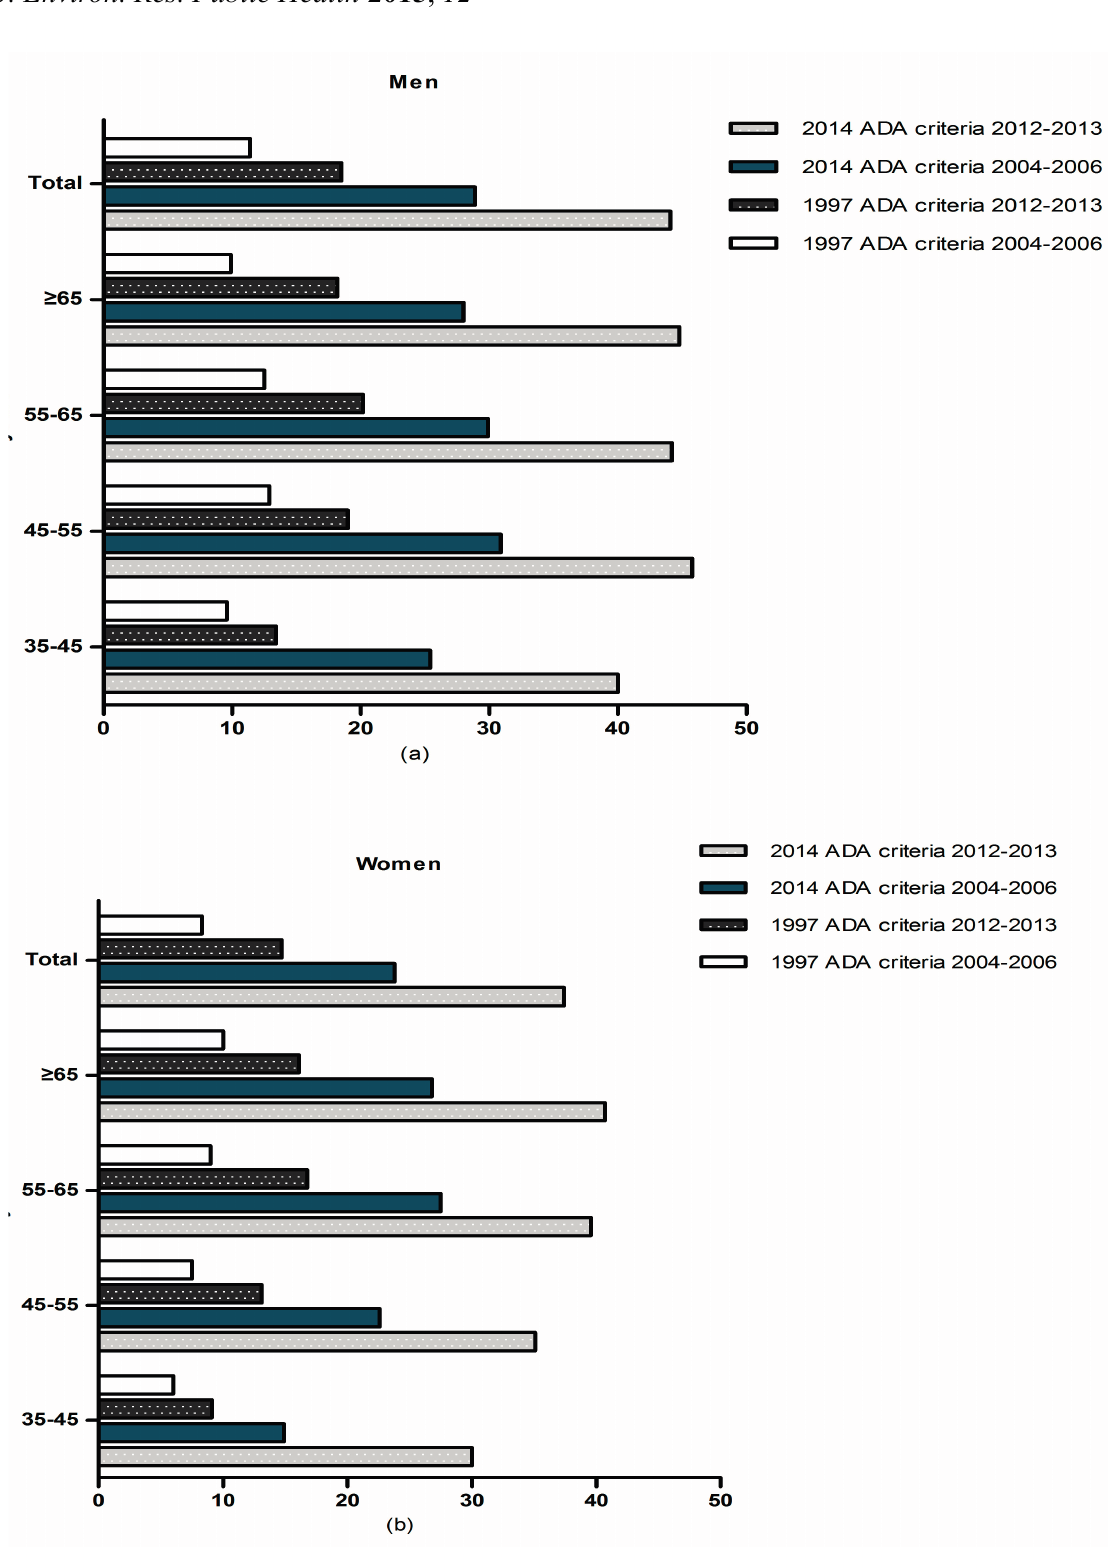
Figure 2. Prevalence of IFG from 2004–2006 years to 2012–2013 years by age in hypertensive ( a ) men, ( b ) women, in rural Northeast